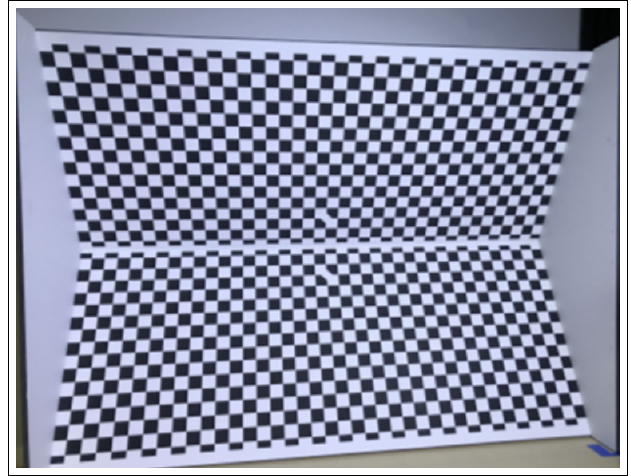
Figure 3. Depth calibration